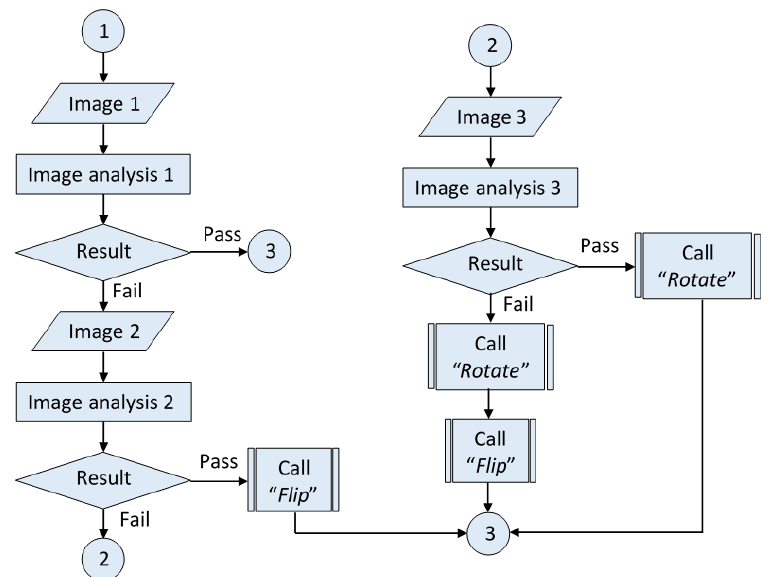
Figure 6. The flowchart for machine vision process, for taking decisions regarding the procedure required to reorient the fuel cell component and for reorienting them.